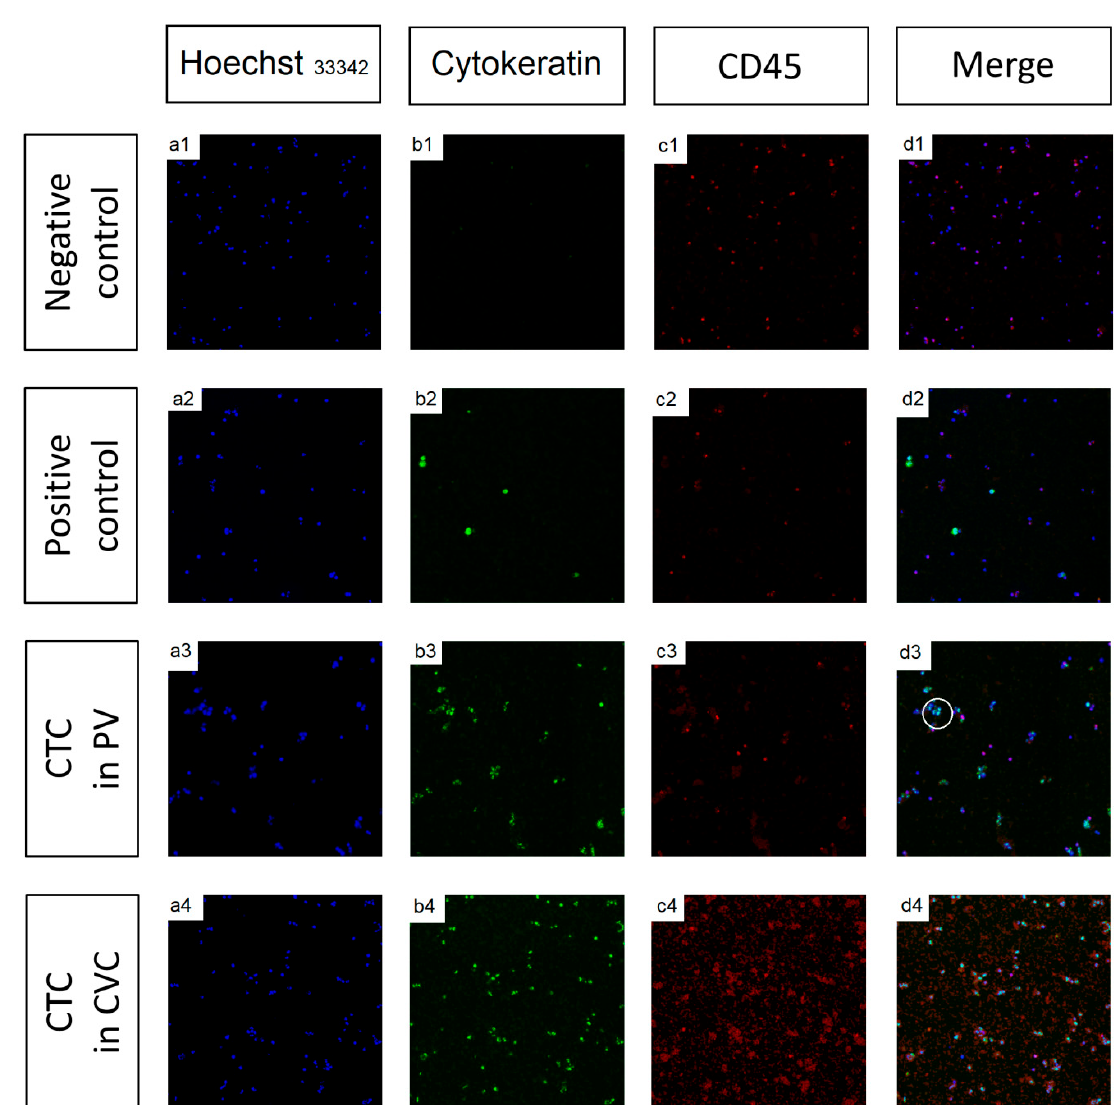
Figure 1. Epifluorescence microscopy pictures. The CTC detection and enumeration were performed by fluorescence microscopy, and the images obtained were processed using image software based on the Hough transform (VR-CTC). The CTC recovery was stained with: ( a ) anti-CK-fluorescein isothiocyanate (FITC) specific for the intracellular protein cytokeratin (characteristic of epithelial cells) (Green); ( b ) anti-CD45-Indocarbocyanine (Cy3) specific for leukocytes (Red); ( c ) Hoechst 33342, used for nuclear staining (Blue); and ( d ) merged image subject to logical operations where we performed a logical multiplication between the thresholding of channels Blue (nuclear) and Green (CK). Finally, we removed the pixels of the thresholding of channel Red (CD45). We eliminated artifacts from the resulting mask using Matlab tools. The white circle in d3 shows the merged image of CTC, which is CK+/CD45 − /nucleated cells; in this way, image pixels are Hoechst+, CK+, and CD45—corresponding to a CTC. Data from ( 1 ) negative control (PMBC), ( 2 ) positive control (PANC-1 cell line), ( 3 ) CTC detected in PVC, and ( 4 ) CTC detected in CVC.